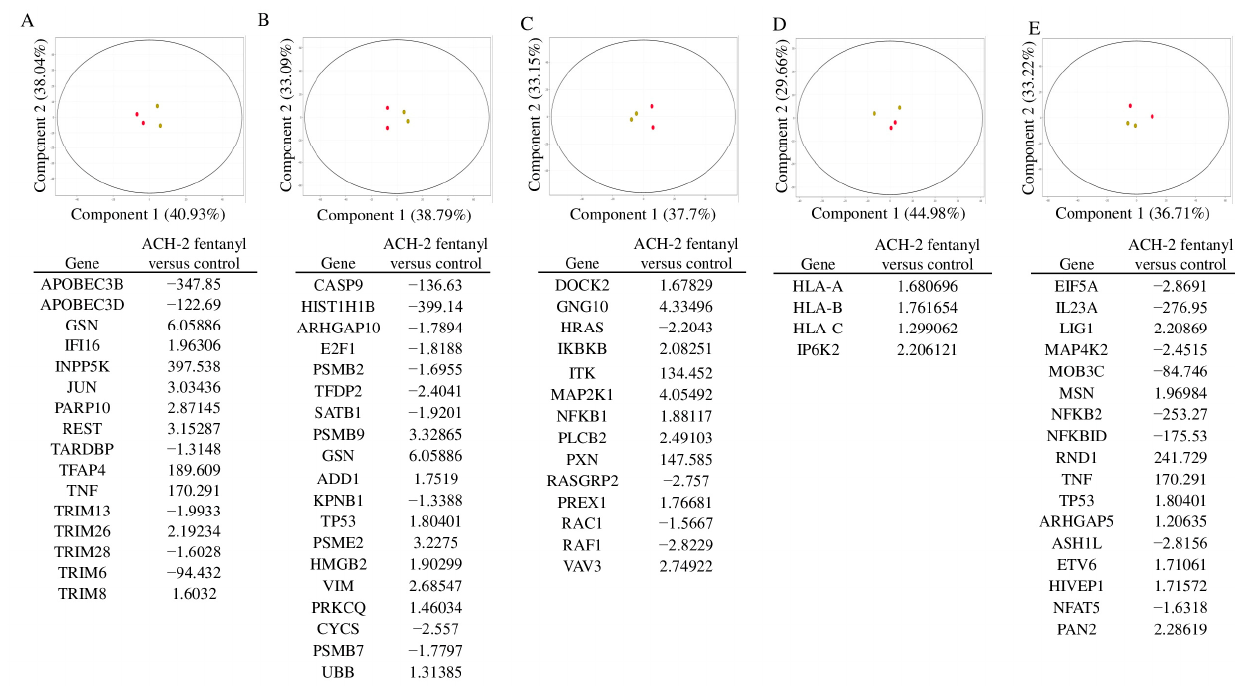
Figure 11. Principal component analysis of the expression of mRNA in ACH-2 cells in the pres- ence/absence of fentanyl: ( A ) antiviral, ( B ) cell death, ( C ) chemokine, ( D ) interferon, and ( E ) NF κ B signaling genes that are significantly differentially expressed (red = no fentanyl, and green = fentanyl-treated).